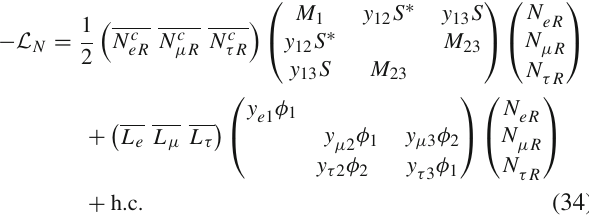
to give the negative corrections and enhance the value of χ 2 τ